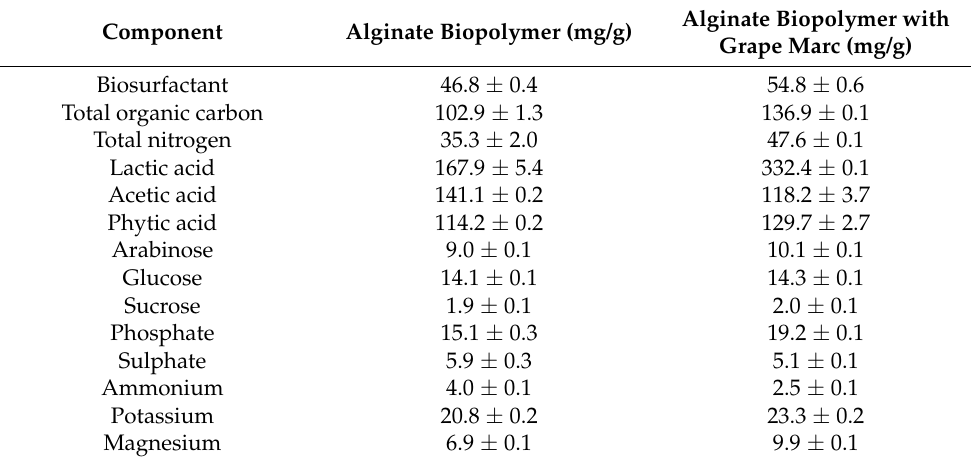
Table 3. Adsorption capacity (mg/g) of some inorganic solutes and biomolecules with the calcium alginate-based biopolymers after 24 h of adsorption process. Component Alginate Biopolymer